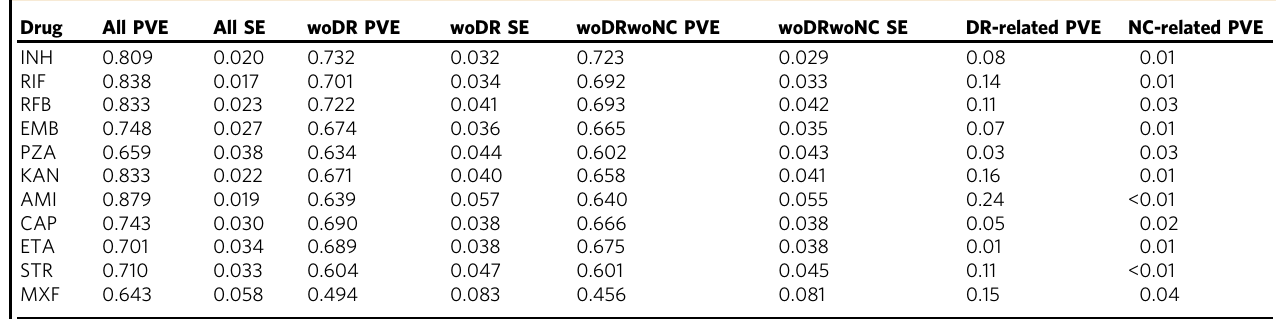
Table 2 PVE for each drug attributable to subsets of genetic variations Drug All PVE All SE woDR